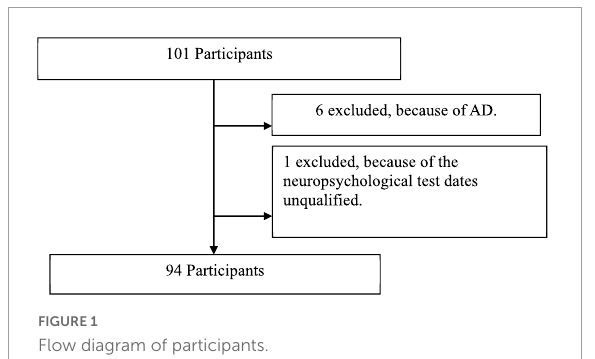
FIGURE1 Flow diagram of